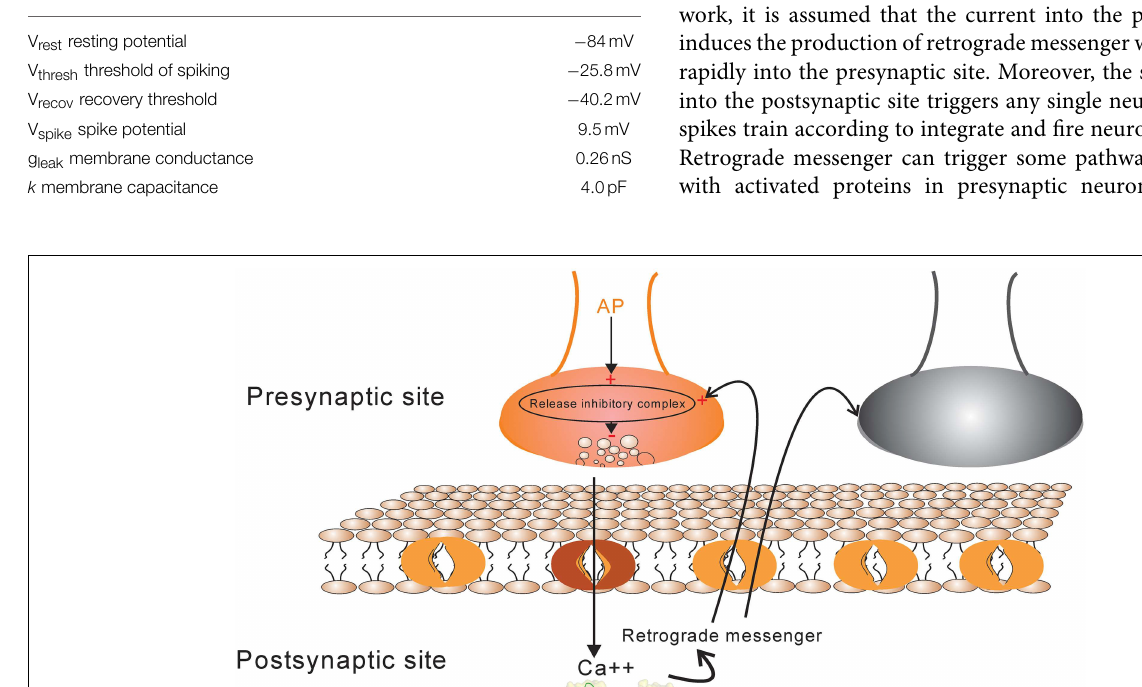
messenger is produced in the postsynaptic site and is released into the presynaptic site where it affects release probability complex. The sum of current influx into the postsynaptic sites triggers a single neuron to generate a spike train in response to a stimulus presentation to the neural population (presynaptic neurons). The spiking pattern of pre-and postsynaptic neurons can modify presynaptic neuron’s activity and synaptic efficacy between pre-and postsynaptic neurons as well by a Hebbian mechanism.